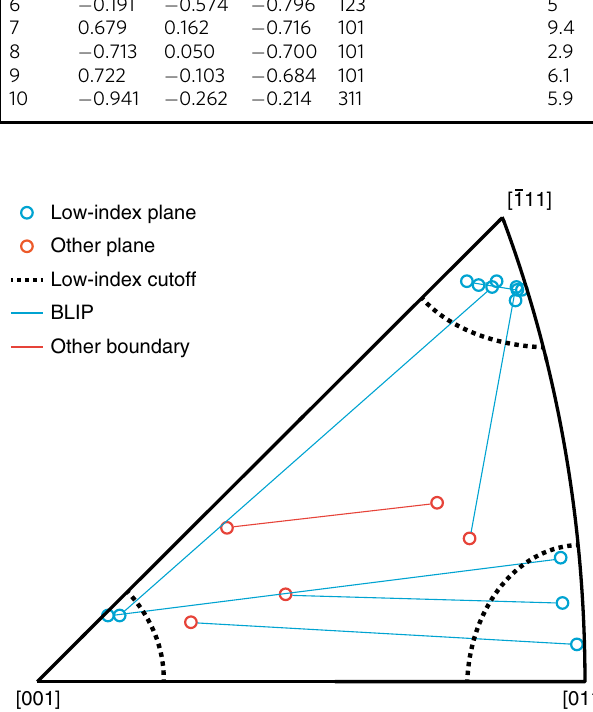
Fig. 3 Crack resistant boundary facets. Orientation of plane normal directions for each pair of grains meeting at the un-cracked grain boundary in a crack de fl ection event (CDE). Plane orientations are expressed as Miller indices in one irreducible triangle of the stereographic projection. Lines connect corresponding planes at individual grain boundaries (GBs), with open circles representing plane normal orientations. Blue circles represent low-index planes, and red circles represent all other planes. Dotted lines indicate the 10° cutoff used to identify planes as low-index. Blue lines indicate boundaries with low-index planes (BLIPs), i.e., boundaries that contain at least one low-index plane, while the red line indicates the single CDE occurring at a GB without any low-index